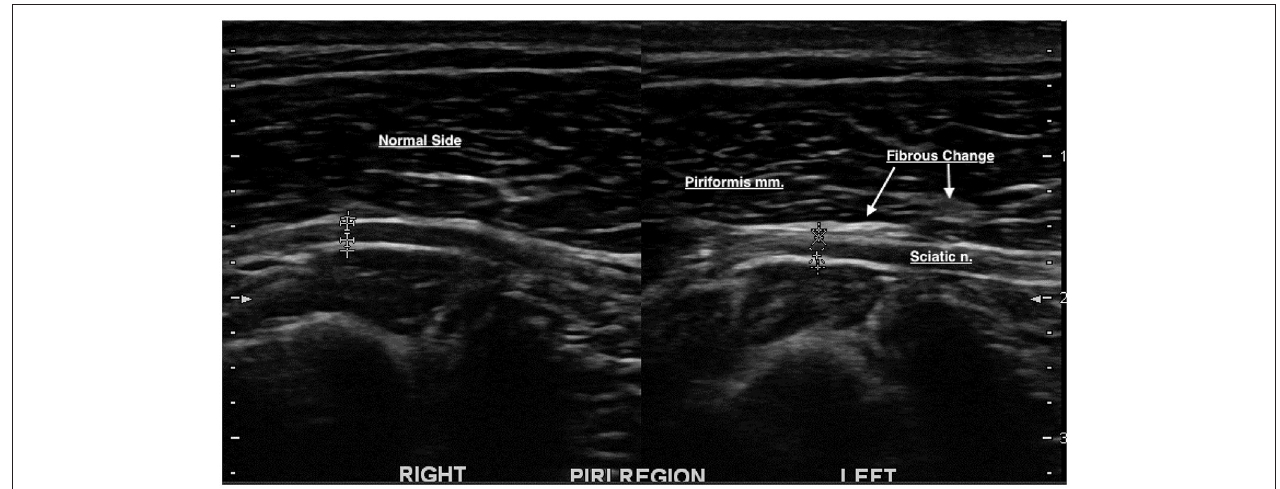
FIGURE 4 | Increased echogenicity/hyperechoic change was noted on the deep piriformis margin on the left side, superficial to the sciatic nerve. Fibrous impingement of the sciatic nerve was also noted.